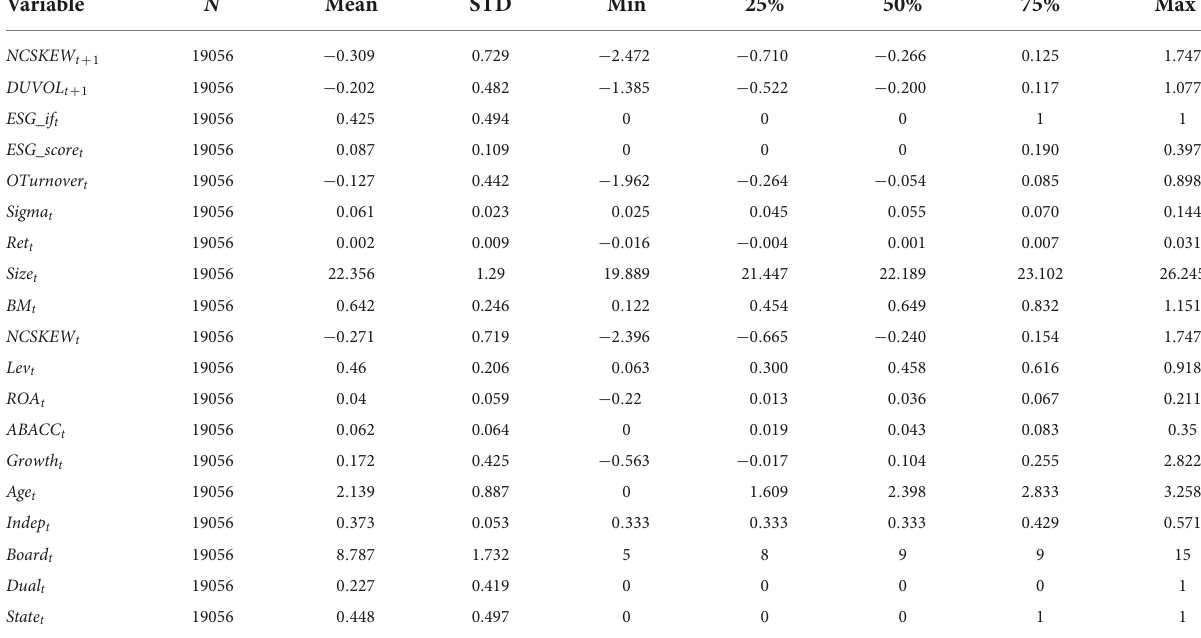
TABLE 1 Summary